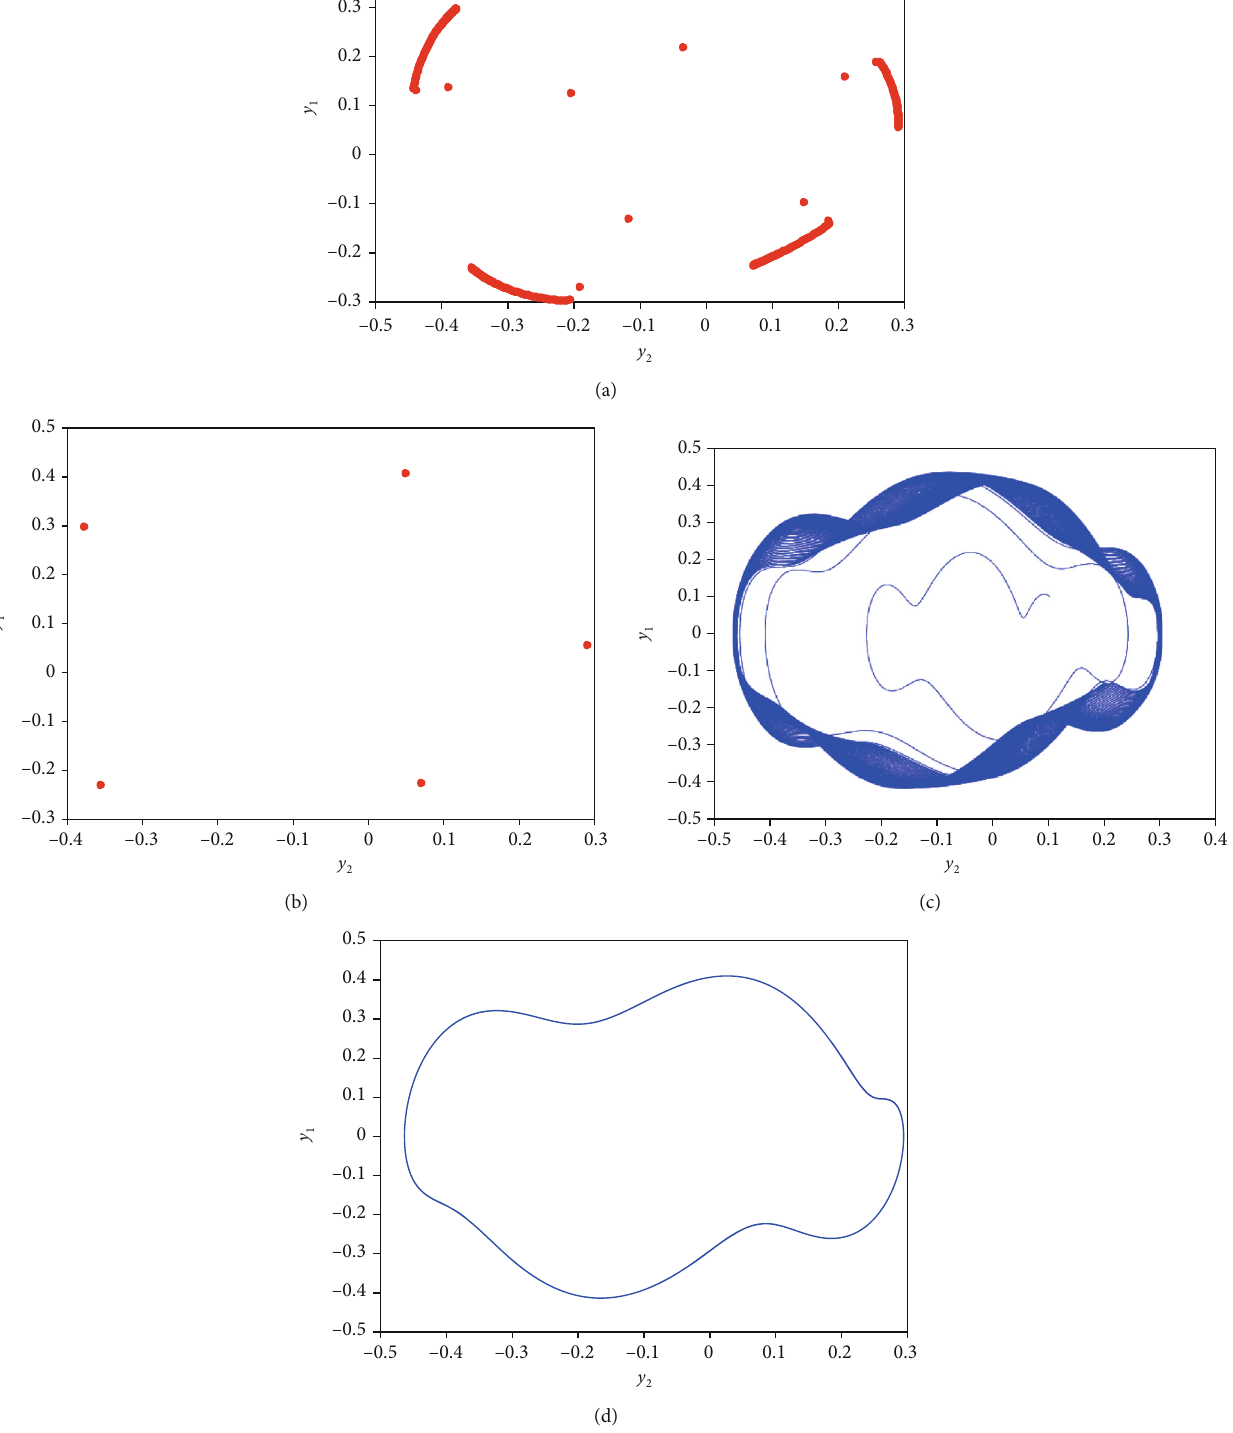
Figure 4: (a) Poincaré map; (b) Poincaré map (last 5000 points); (c) phase diagram; (d) phase diagram (last 10000